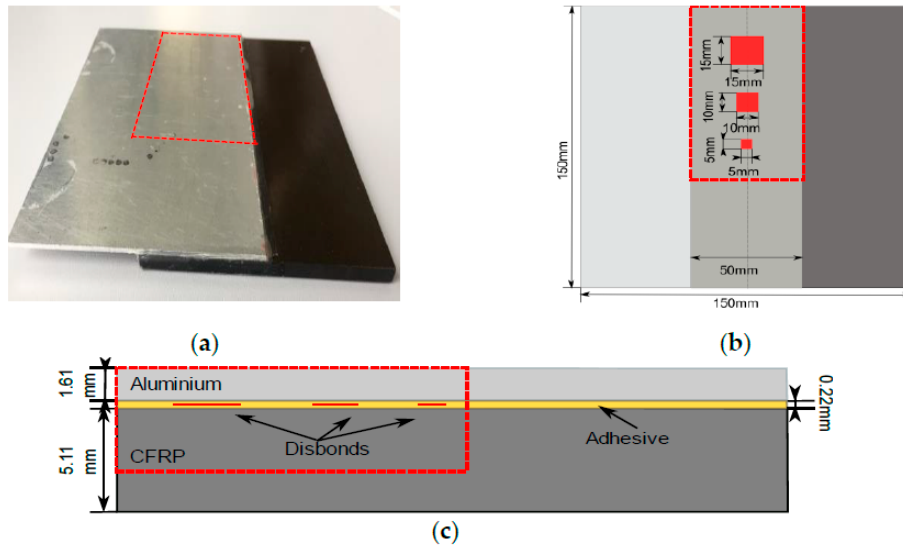
Figure 1. Single-lap joint of dissimilar materials under investigation: ( a ) Photo with indicated region of disbonds location; ( b ) Top view scheme of the component and defects dimension; ( c ) Cross-sectional view of the component and defects.